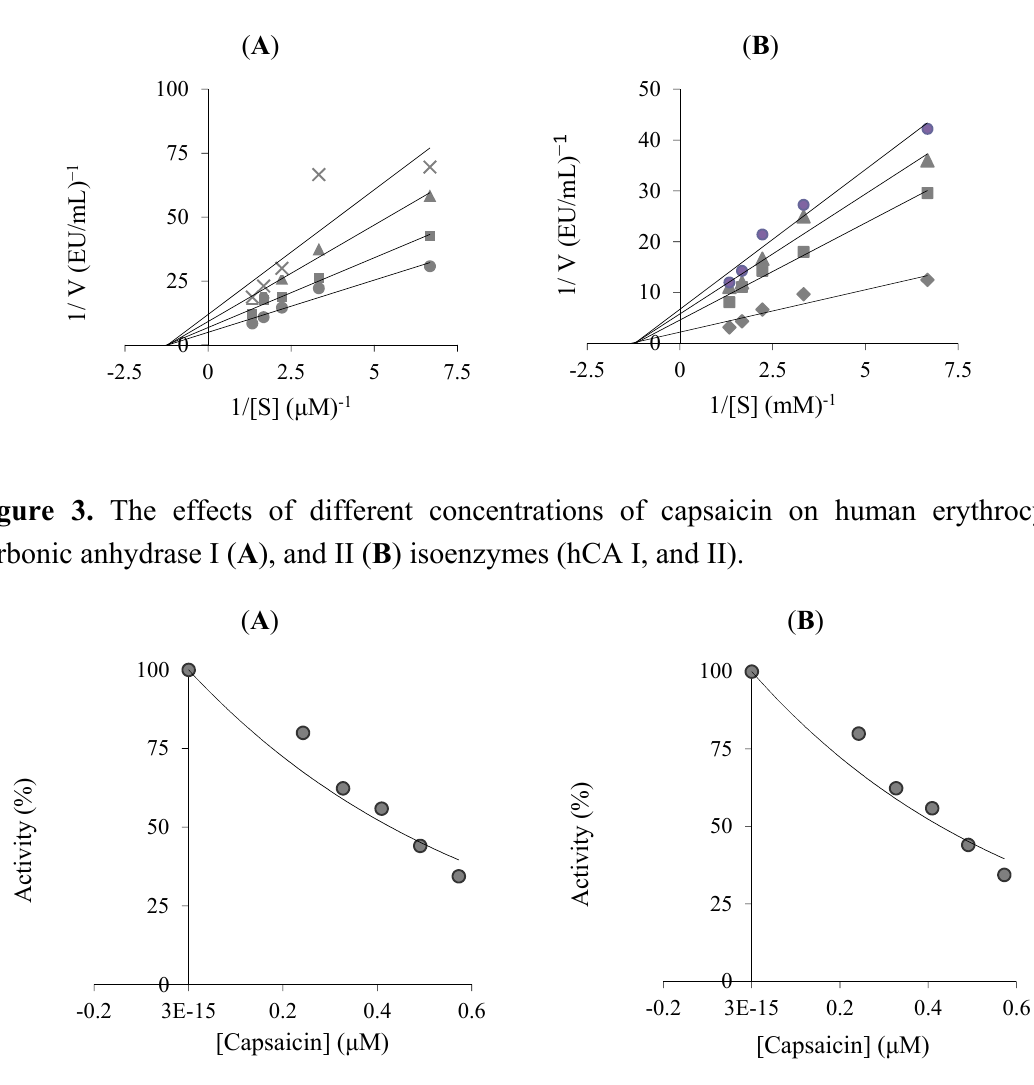
Figure 2. Determination of Ki values of capsaicin for human erythrocyte carbonic anhydrase I ( A ), and II ( B ) isoenzymes (hCA I, and II) by Lineweaver-Burk plots.